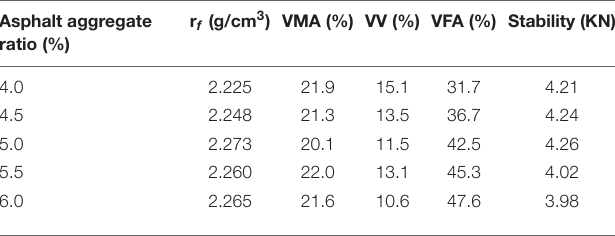
TABLE 6 | Test results of volume parameters and mechanical indices of finished formed specimens.